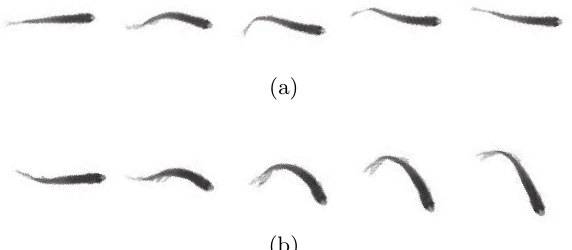
Figure 1: Zebrafish burst-and-coast swimming in successive video frames samples at 30 frames per second. (a) A single tail flick can propel the fish for- ward and (b) fish can change its orientation in just a few